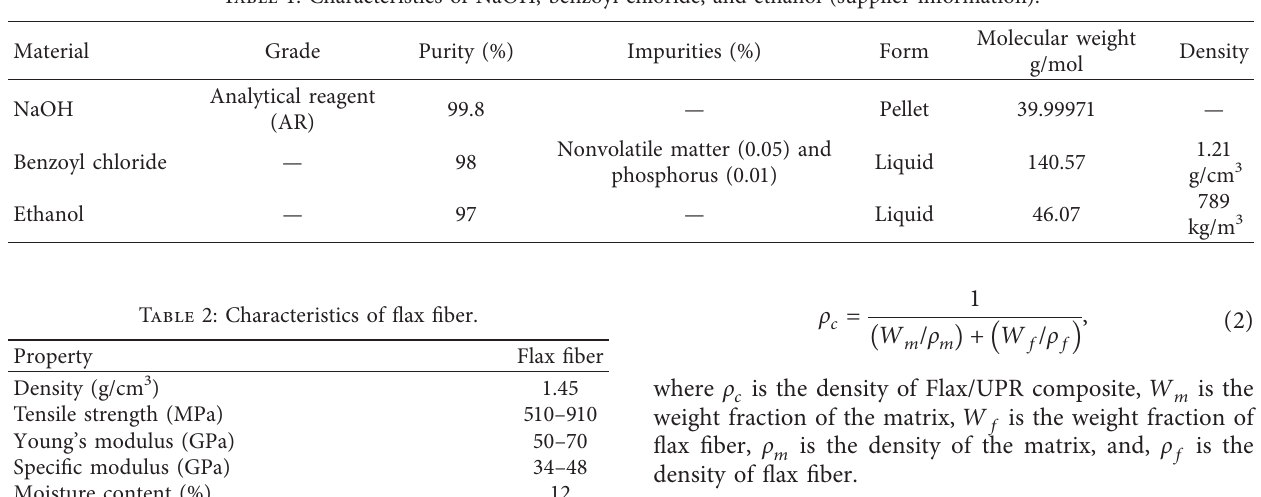
Table 1: Characteristics of NaOH, benzoyl chloride, and ethanol (supplier information).